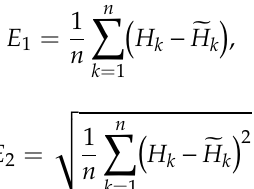
Figure 16. The experimental results of low-resolution images (640 × 360 px): ( a )–( d ) is experiment corresponding to the first group experiment III, which is line segment extraction, line segment matching, line segment pool rough selection and line segment pool fine selection. ( e )–( h ) is experiment corresponding to the first group experiment IV.